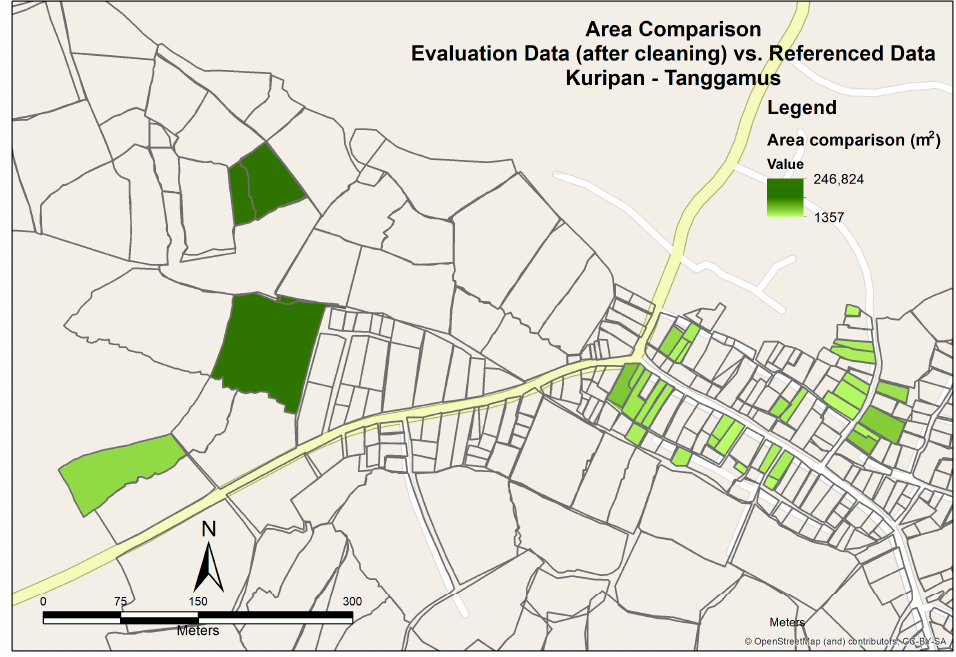
Figure 6. Map of area comparisons between the evaluation and reference dataset in Tanggamus .